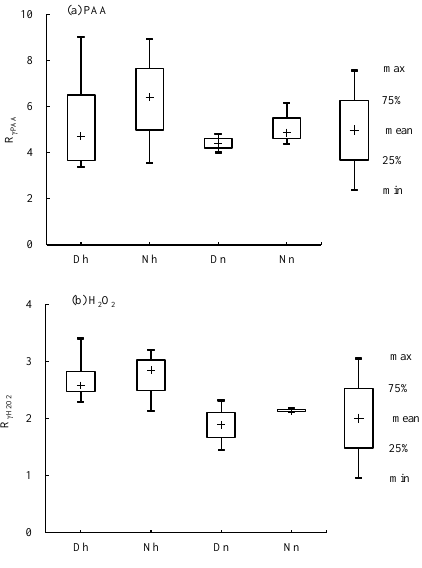
Figure 6. The ratio of γ at 90%RH to γ at 3%RH ( R γ PAA and R γ H ) on PM 2 . 5 . Dh, daytime of haze day; Nh, nighttime of haze 2 O 2 day; Dn, daytime of non-haze day; Nn, nighttime of non-haze day.